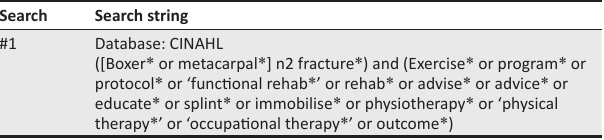
TABLE 1 : Database search keywords. Search